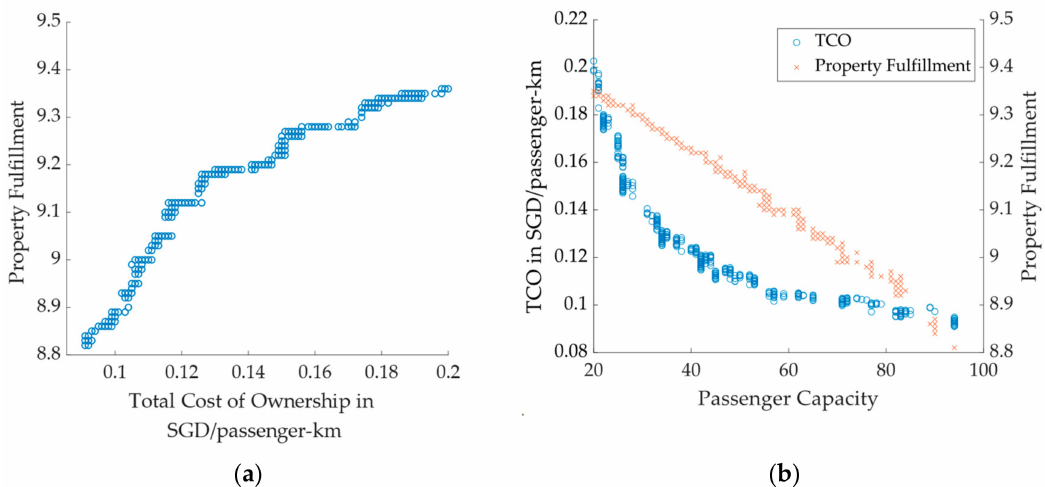
Figure 9. ( a ) Pareto optimal solutions of the vehicle concepts for the analyzed route. ( b ) The effect of vehicle size on the costs and value to the